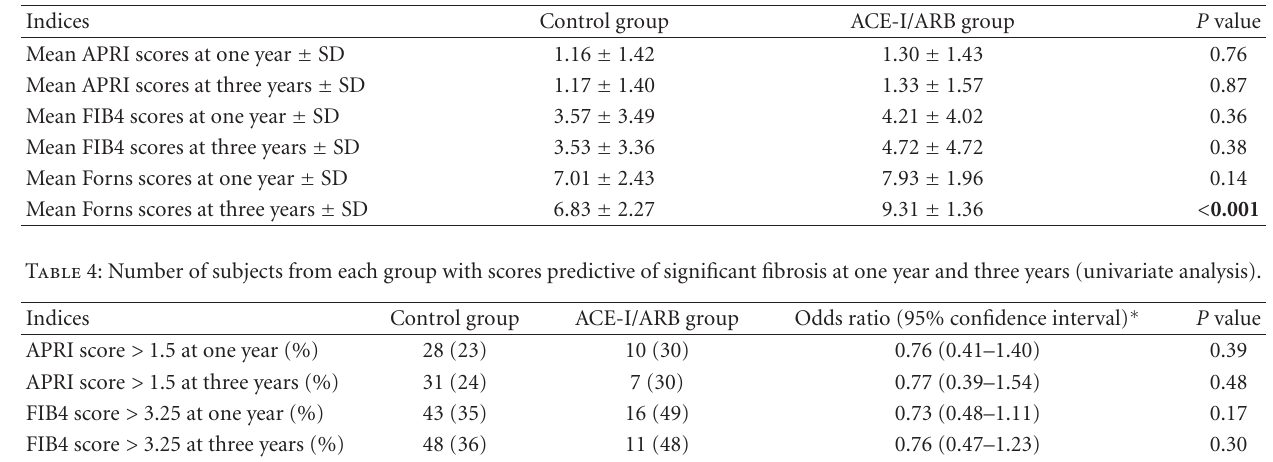
Table 3: Comparison of continuous fibrosis scores between groups at one year and three years (univariate analysis). Indices